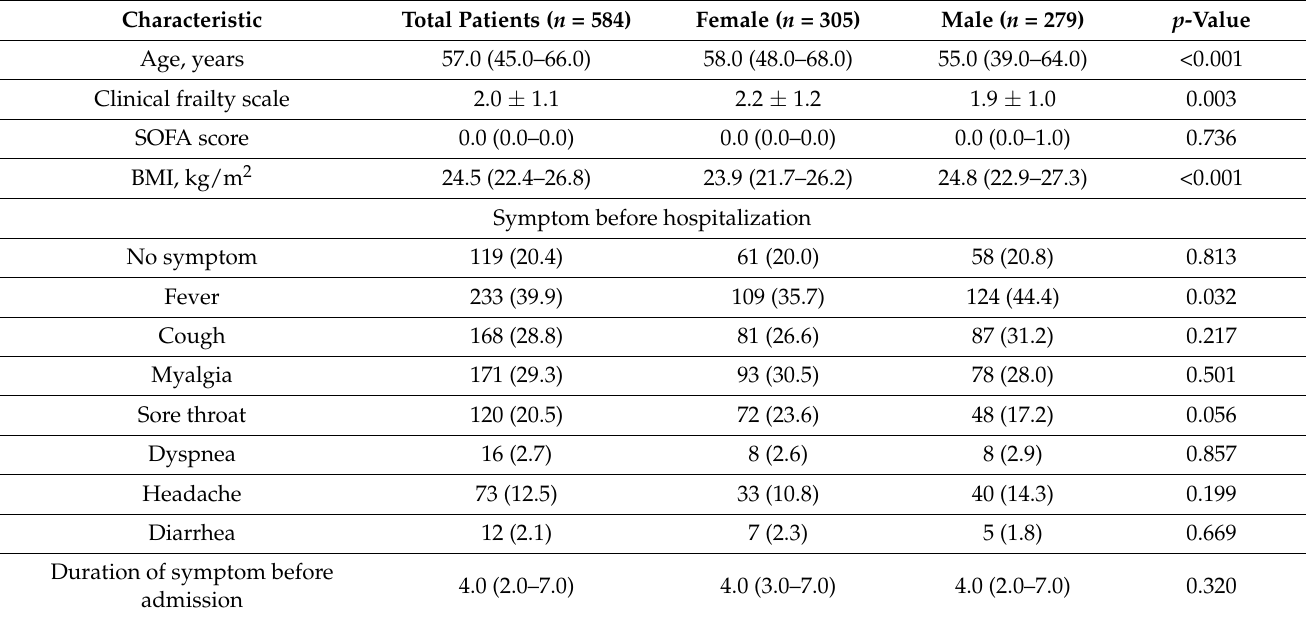
Table 1. Baseline characteristics and clinical features of the study population.